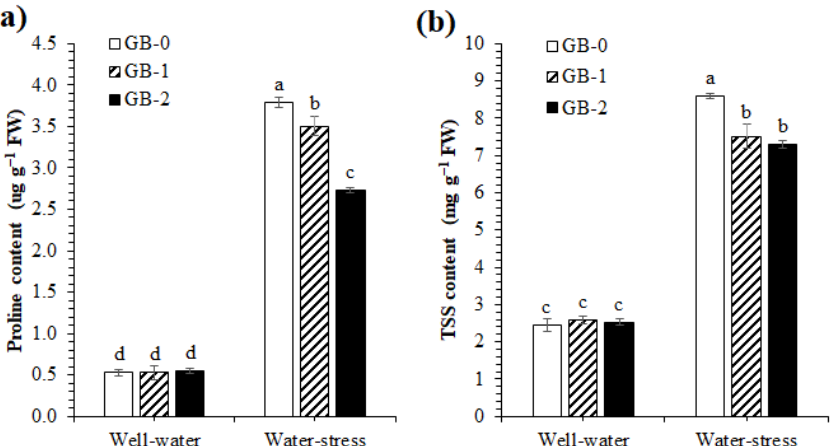
Figure 4. Effect of GB root-priming on proline ( a ) and total soluble sugars content ( b ) in the roots of wheat seedling grown under well-water and water-stress conditions. Each value represents the mean ± standard deviation (SD) of three replicates. Bars showing different letters represent the significant differences at p ≤ 0.05 as determined by LSD test.